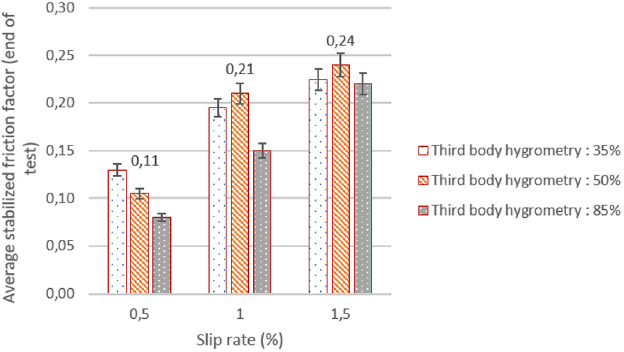
Fig. 15. Average stabilized friction factor (and standard devi- ation) obtained at the end of the tests performed with various slip rates and RH values of the third